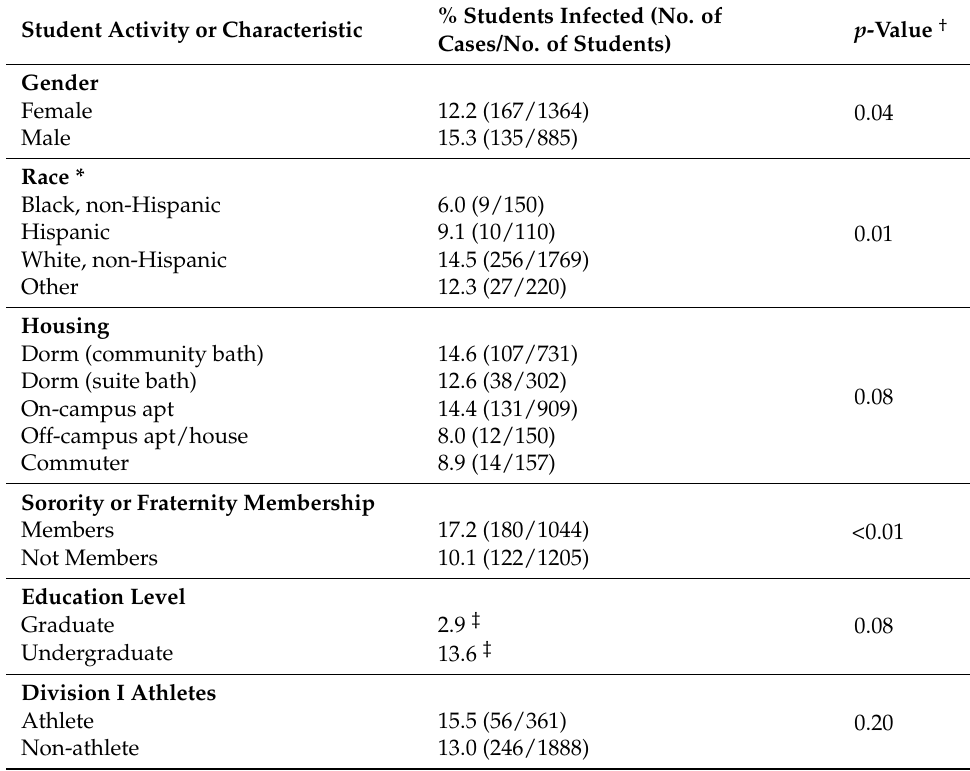
Table 3. Characteristics associated with confirmed COVID-19 cases during the academic year at